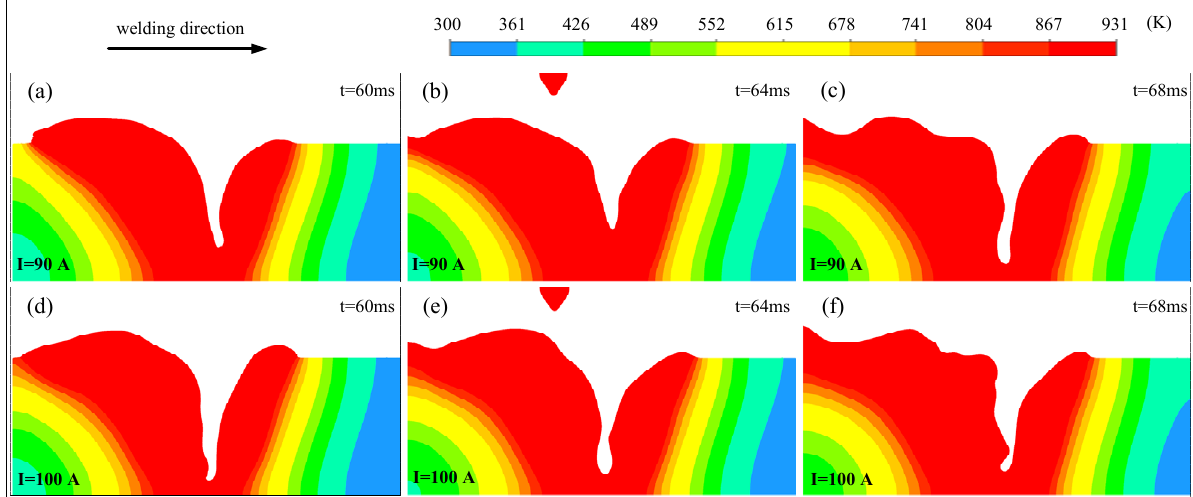
Figure 7. Simulation results of temperature field in keyhole evolution process under different arc currents. ( a – c ) I = 90 A; ( d – f ) I = 100 A.